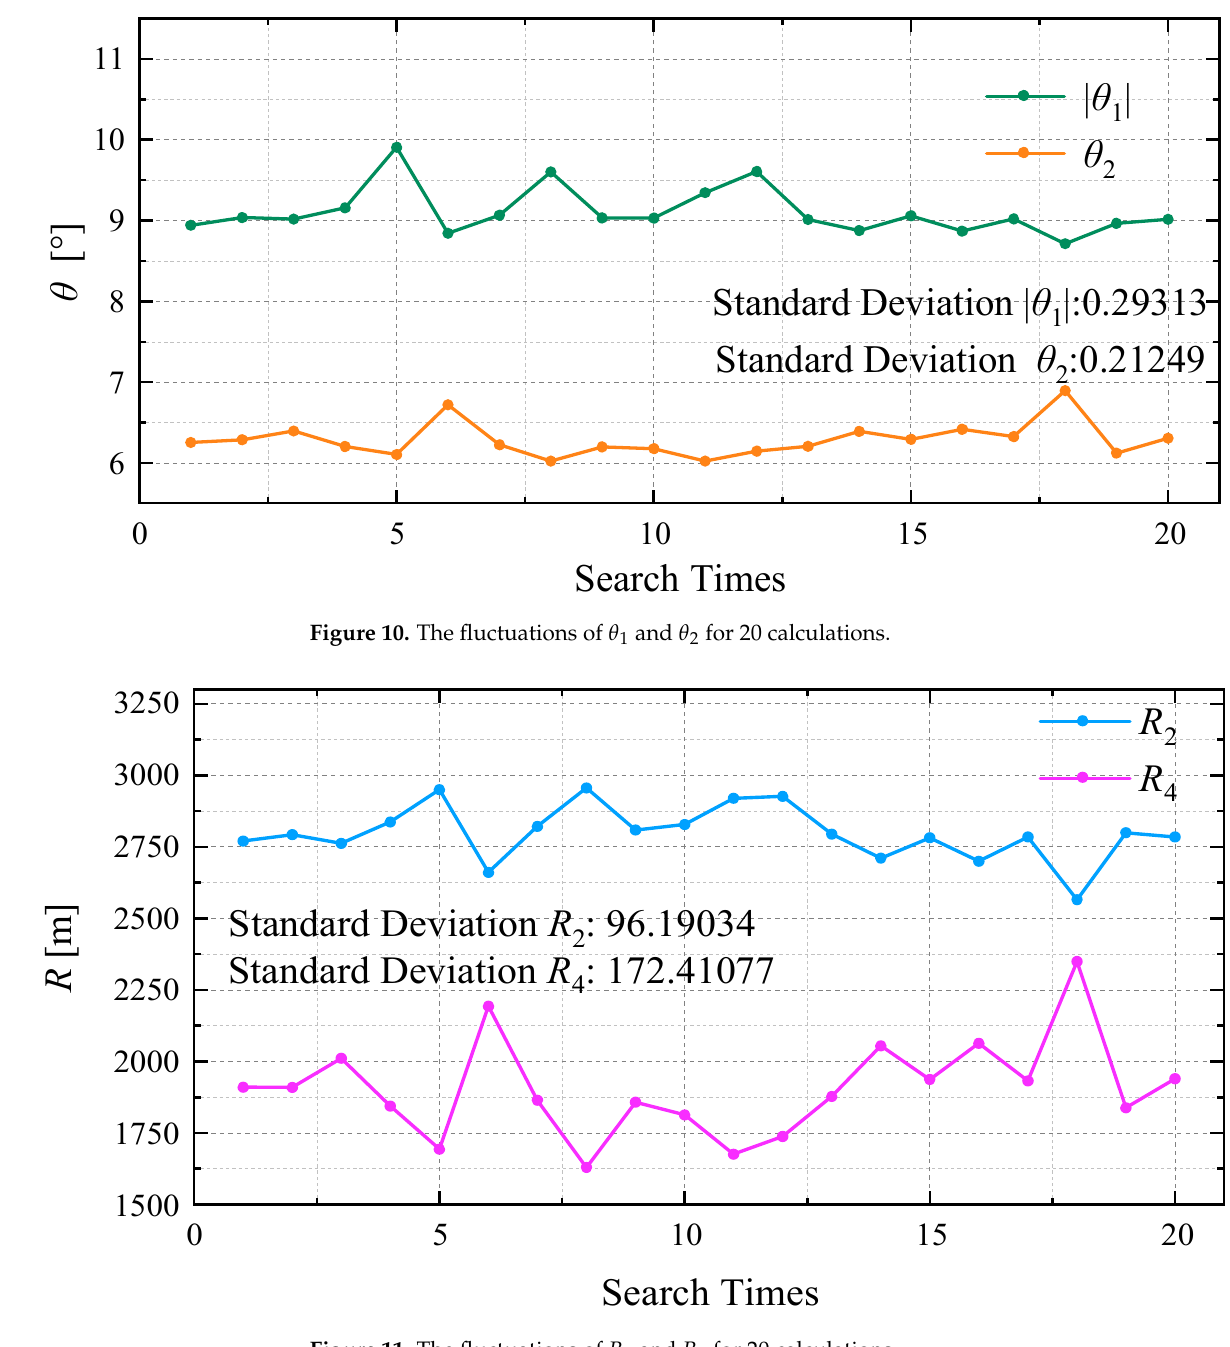
Figure 12. The fluctuations of L 1 and L 3 for 20 calculations. Wi ś niowski et al. [19] suggested fixing the length of the central segment L 3 and nar- rowing the ranges of the other parameters to further optimize the five-segment trajectory